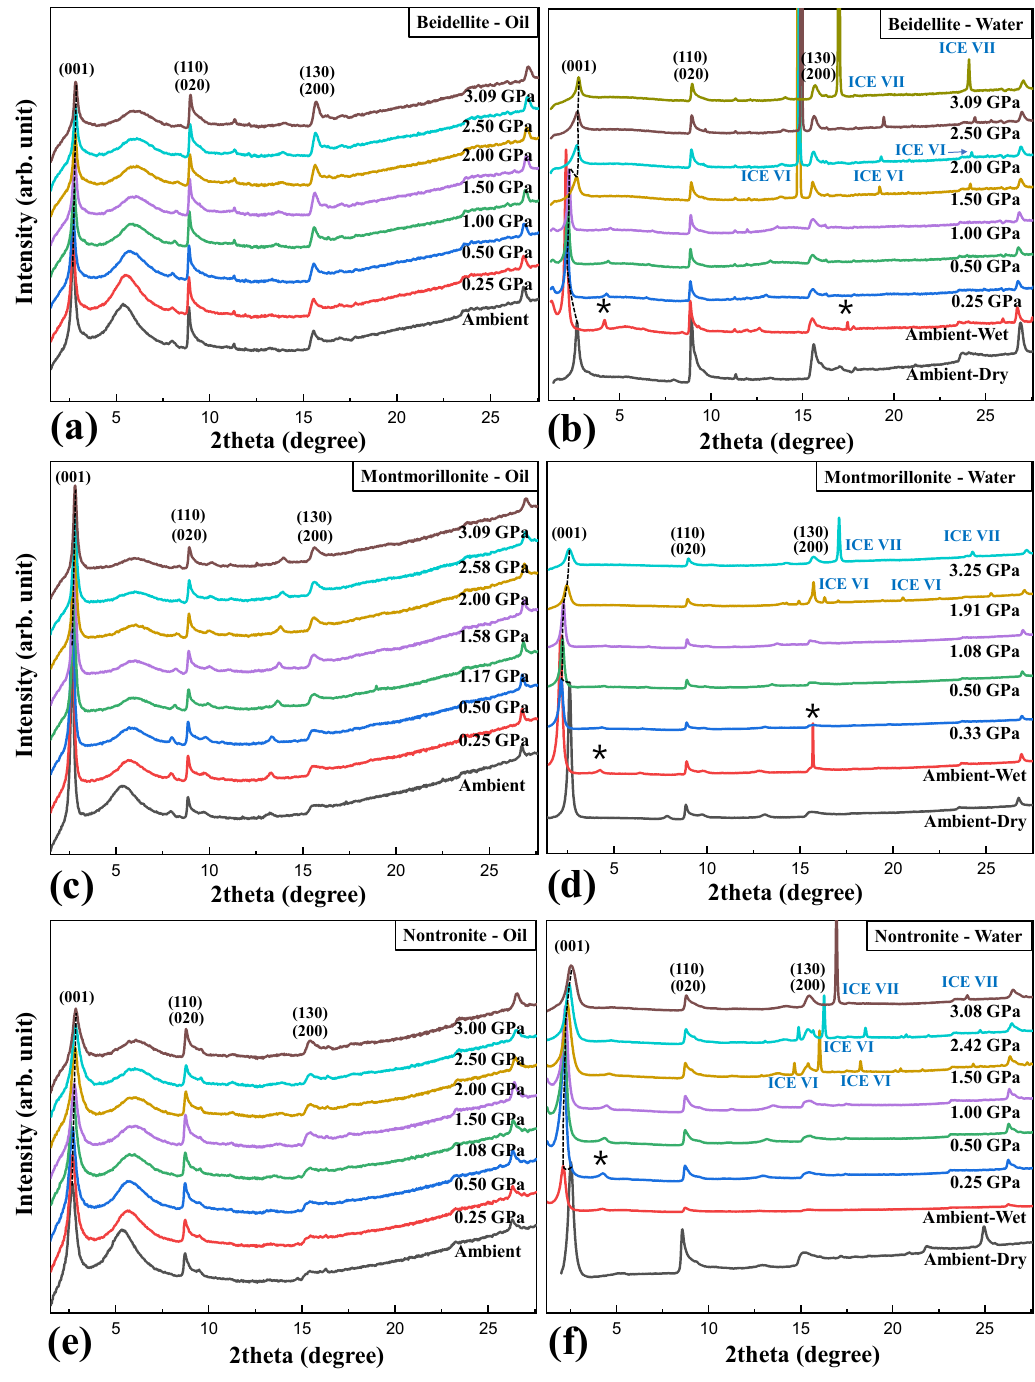
Figure 2. In-situ high-pressure synchrotron X-ray powder diffraction patterns of beidellite, montmorillonite, and nontronite in silicone oil and distilled water pressure transmitting media (PTM) for anhydrous and hydrous environments at room temperature. Each stacked pattern represents ( a ) beidellite oil, ( b ) beidellite water, ( c ) montmorillonite oil, ( d ) montmorillonite water, ( e ) nontronite oil, and ( f ) nontronite water, respectively. Selected Miller indices are shown. The reflections of impurities are marked as asterisks. The humps near 5.5 to 6 degrees in 2-theta in silicone oil data indicate short-range ordering of silicon oil PTM.